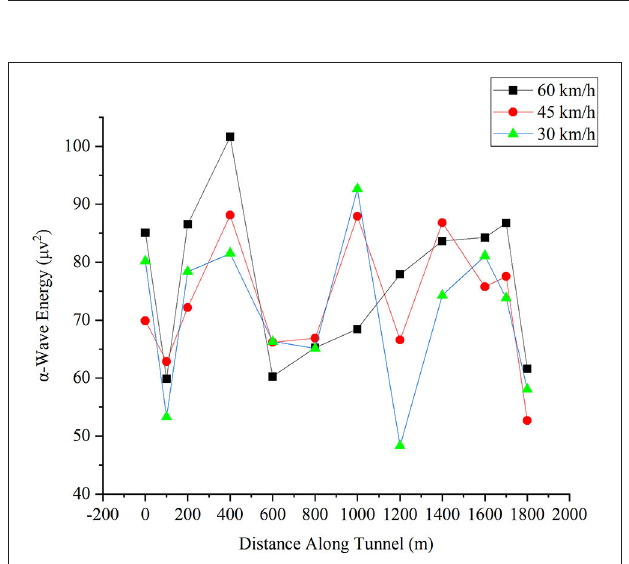
FIGURE 5 | EEG topographic maps of the three waves of drivers for different speeds.